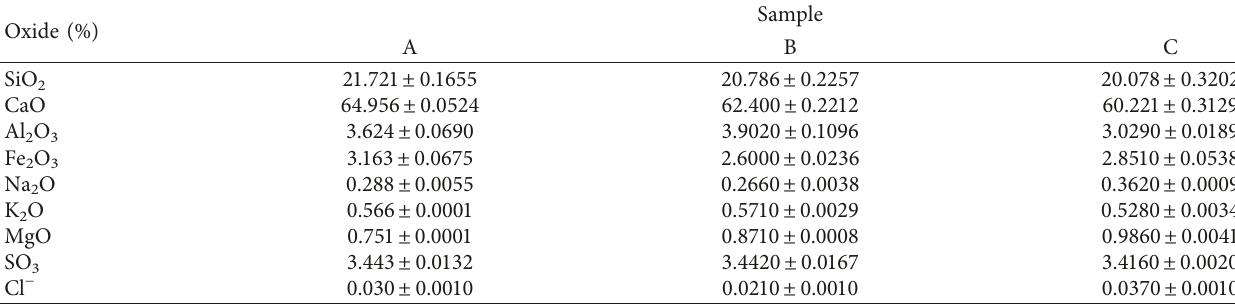
Table 1: Results for chemical analysis of the test cements in percent by mass.